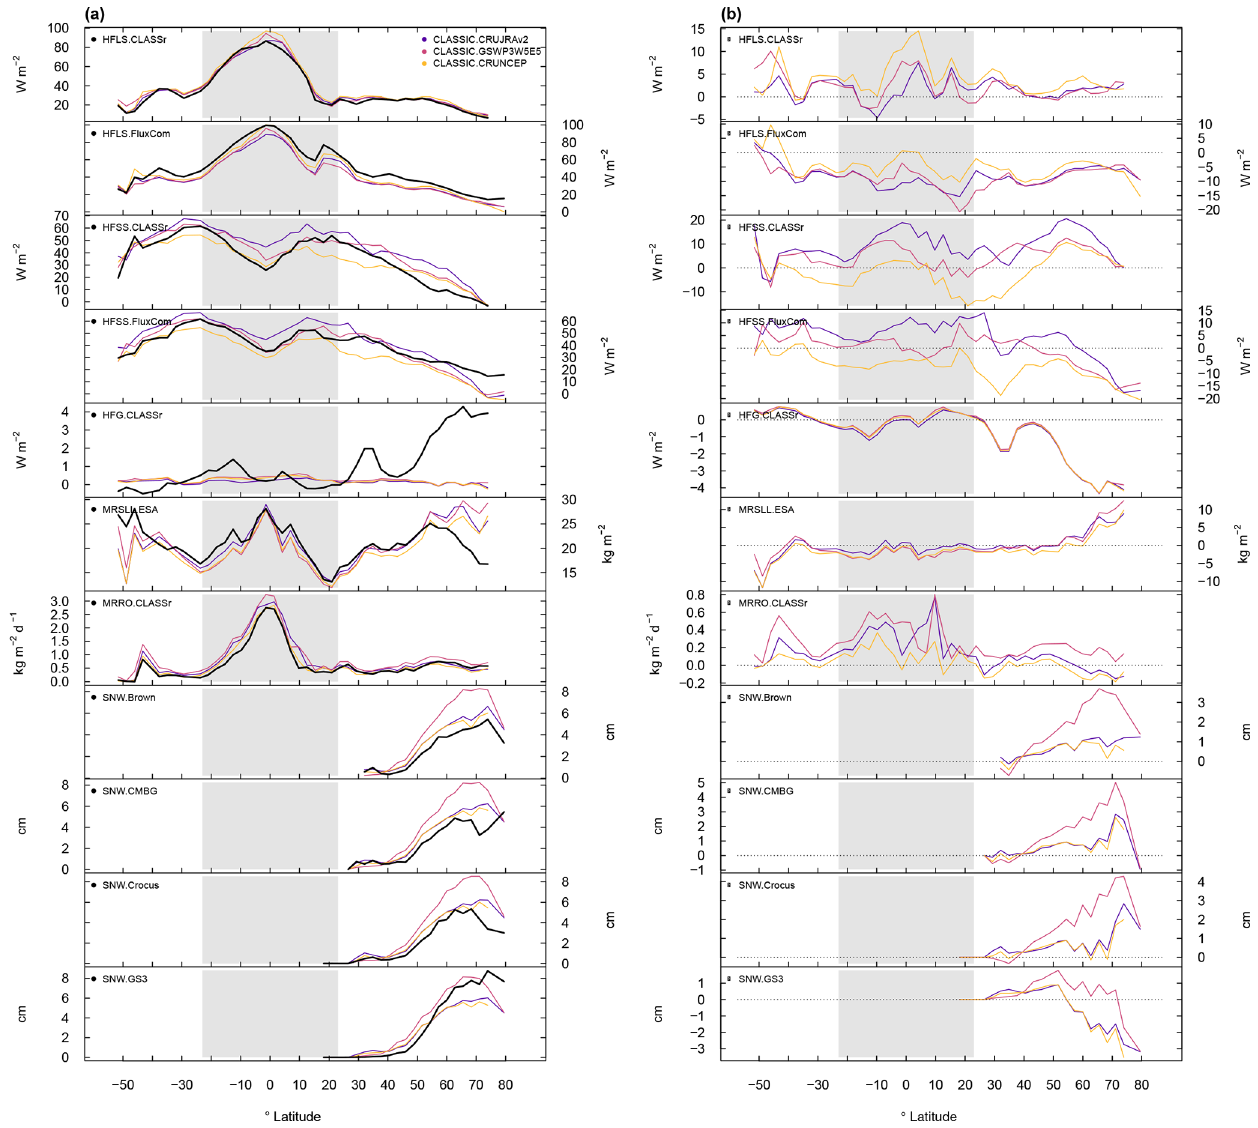
Figure 11. (a) Zonal mean values and (b) corresponding biases for heat fluxes and variables related to the water